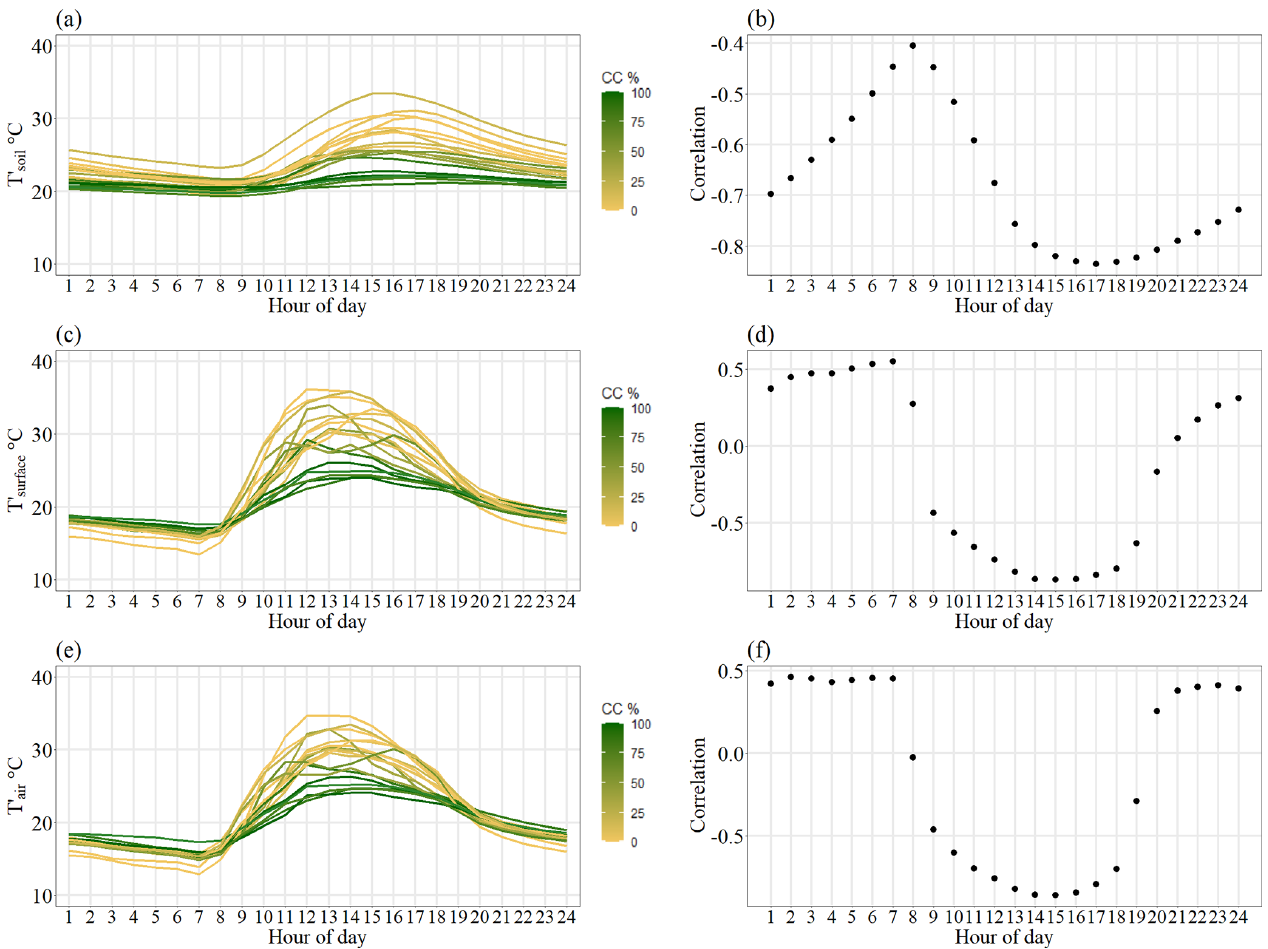
Figure 5. Topographically corrected diurnal mean temperatures ( T (cid:48) ) (a, c, e) and the correlation between T (cid:48) and canopy cover (CC) percent- age (b, d, f) between 13 June and 10 July 2019. Hour refers to ordinal number of hour, e.g., 1 means 00:00–01:00. Line color indicates CC